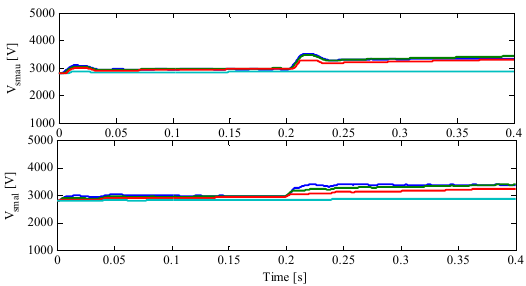
Figure 16. SM voltages of MMC with input MMC current variation.